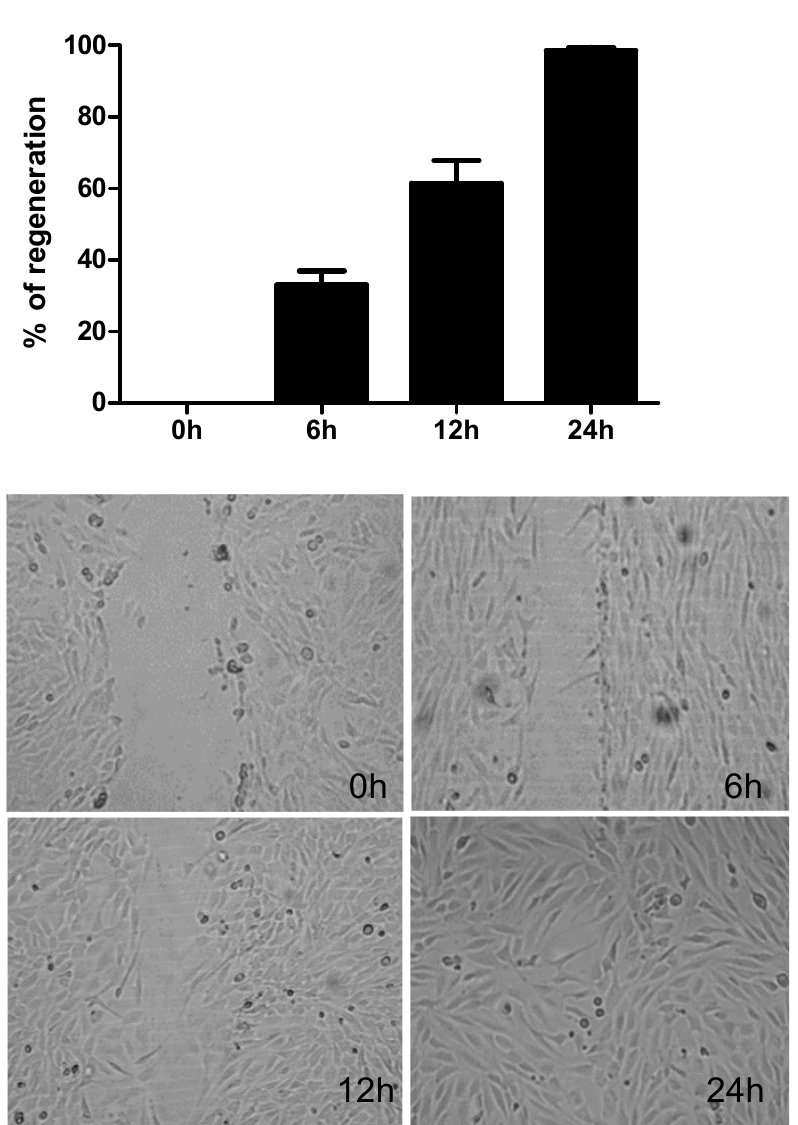
Figure 1. Wound repair in epithelial cells in response to mechanical injury. The magnification is 100×.